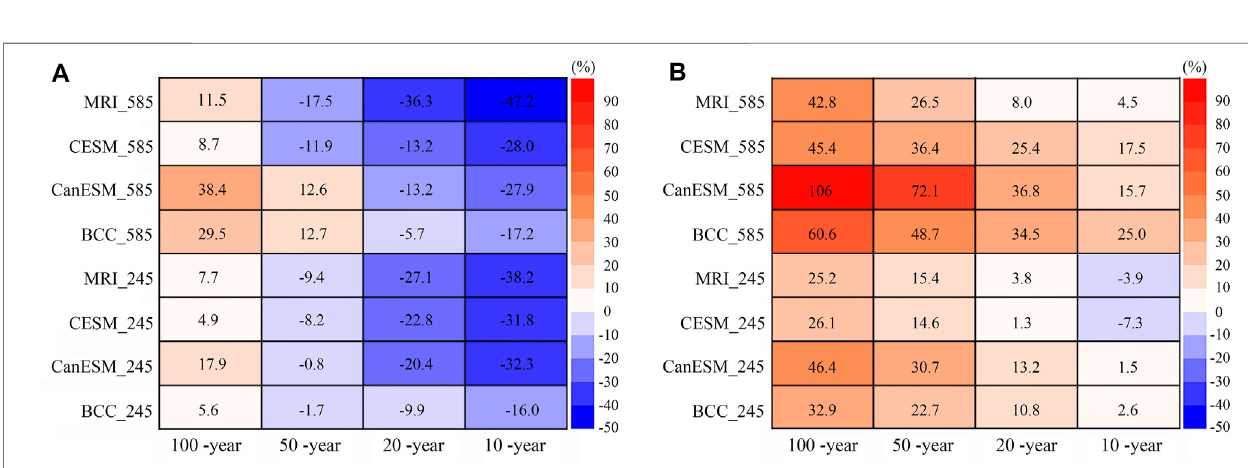
Frontiers in Environmental Science |